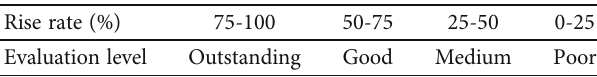
Table 4: Teacher ’ s teaching e ff ect quanti fi cation table. Rise rate